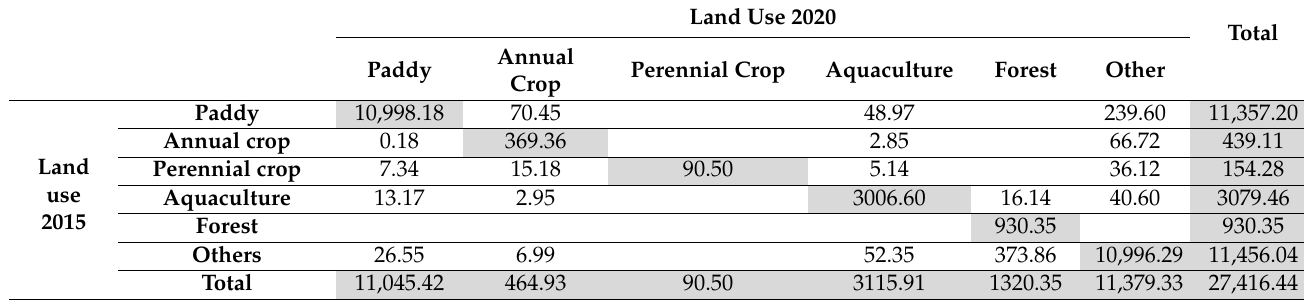
Table 7. Land-use change matrix between 2015 and